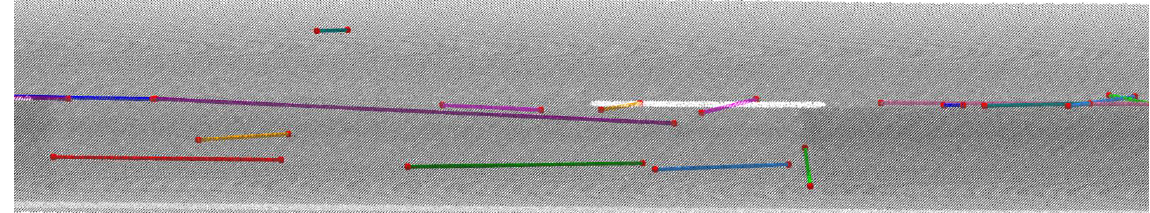
Figure 6. Crack point clusters are represented as graphs.